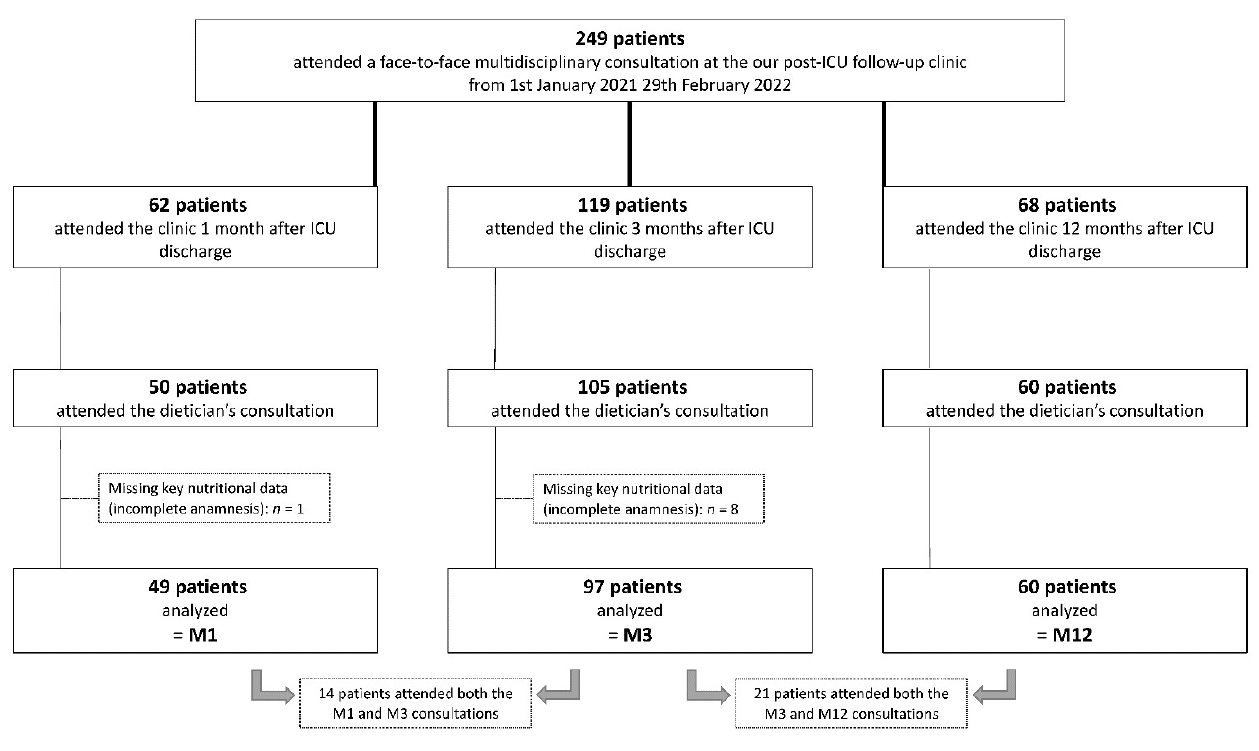
Figure 1. Flow chart.